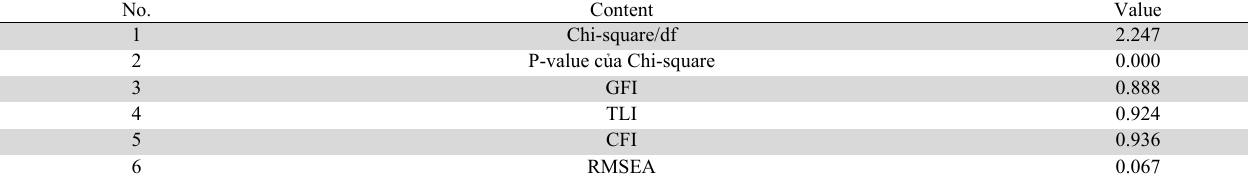
SEM analysis results according to standardized coefficients